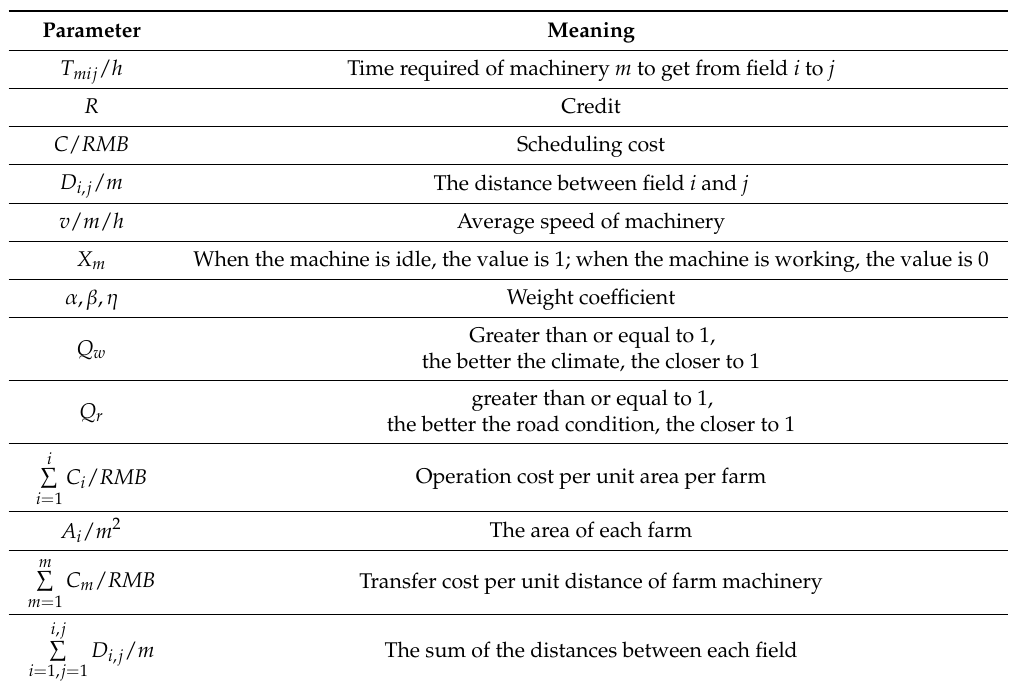
Table 4. Scheduling